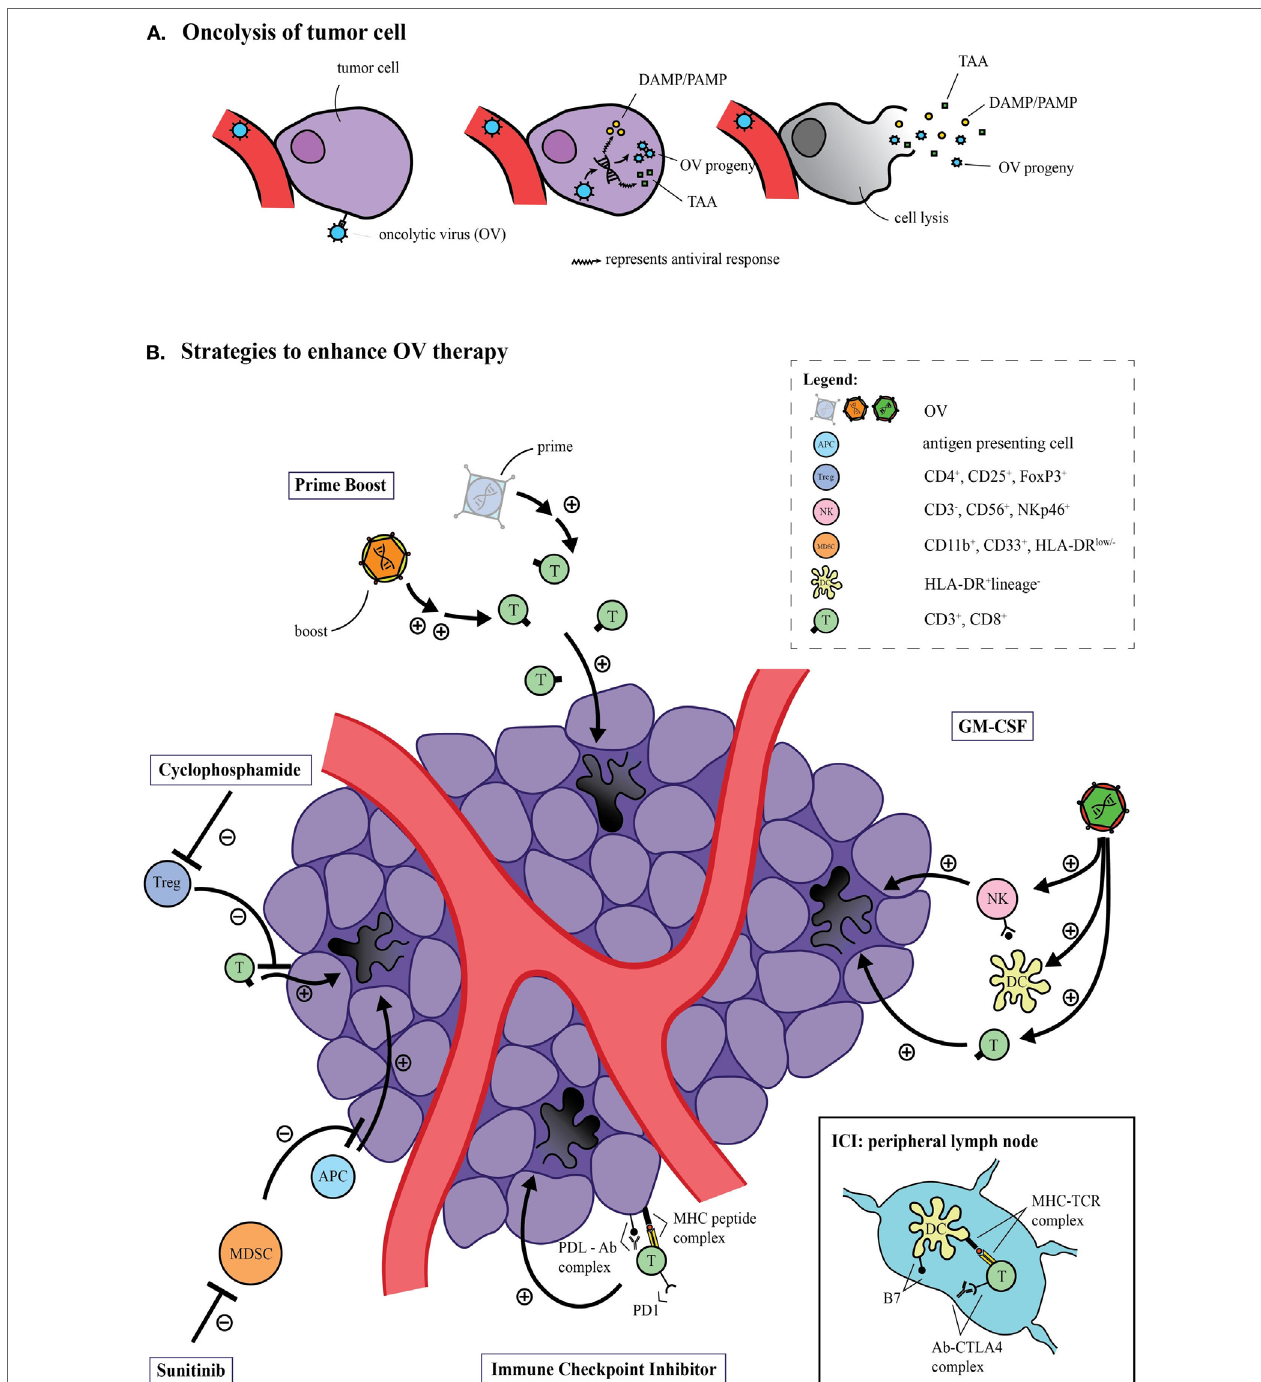
FiGURe 1 | Oncolytic virus (OV)-mediated tumor cell lysis. (a) OV can specifically infect cancer cells, and subsequent replication can induce oncolysis. The release of tumor antigens has the potential to activate a systemic antitumor immune response. (b) The immune response induced by OV can be improved through several strategies. The prime-boost approach utilizes one priming viral platform carrying tumor-specific antigens, while a second platform—usually an OV—carrying the same antigens boosts the resultant antitumor immune response. The insertion of transgenes, such as GM-CSF, can facilitate antigen presentation on the surface of dendritic cells, and thus augment an antitumor response by recruiting natural killer (NK) cells and inducing tumor-specific cytotoxic T-cells. Immune checkpoint inhibitors can function both at the level of the tumor, targeting the programmed cell death protein 1 (PD-1) axis or peripherally at the level of the lymph nodes by targeting the cytotoxic T lymphocyte-associated antigen 4 (CTLA-4) axis. Both approaches ultimately improve the antitumor response. Immunomodulatory drugs such as sunitinib and cyclophosphamide can augment the antitumor immune response of OV by inhibiting immunosuppressive populations, such as myeloid- derived suppressor cells (MDSCs) and regulatory T cells (Tregs), respectively.